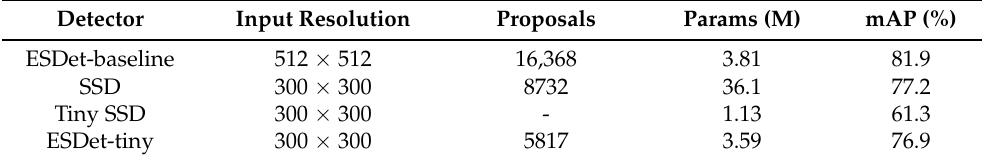
Table 8. Comparison of the compressed